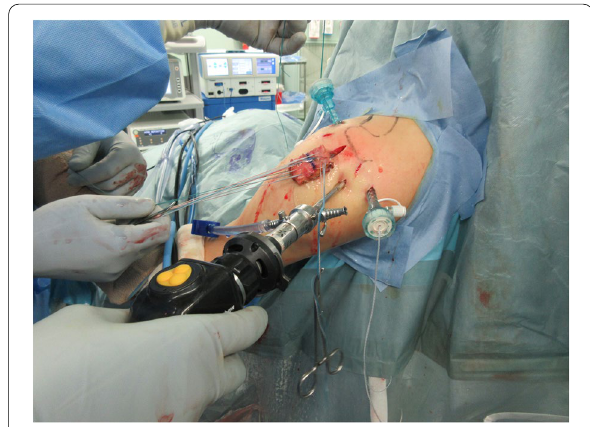
Fig. 2 Graft insertion. The graft was inserted into the subacromial space through the enlarged lateral portal